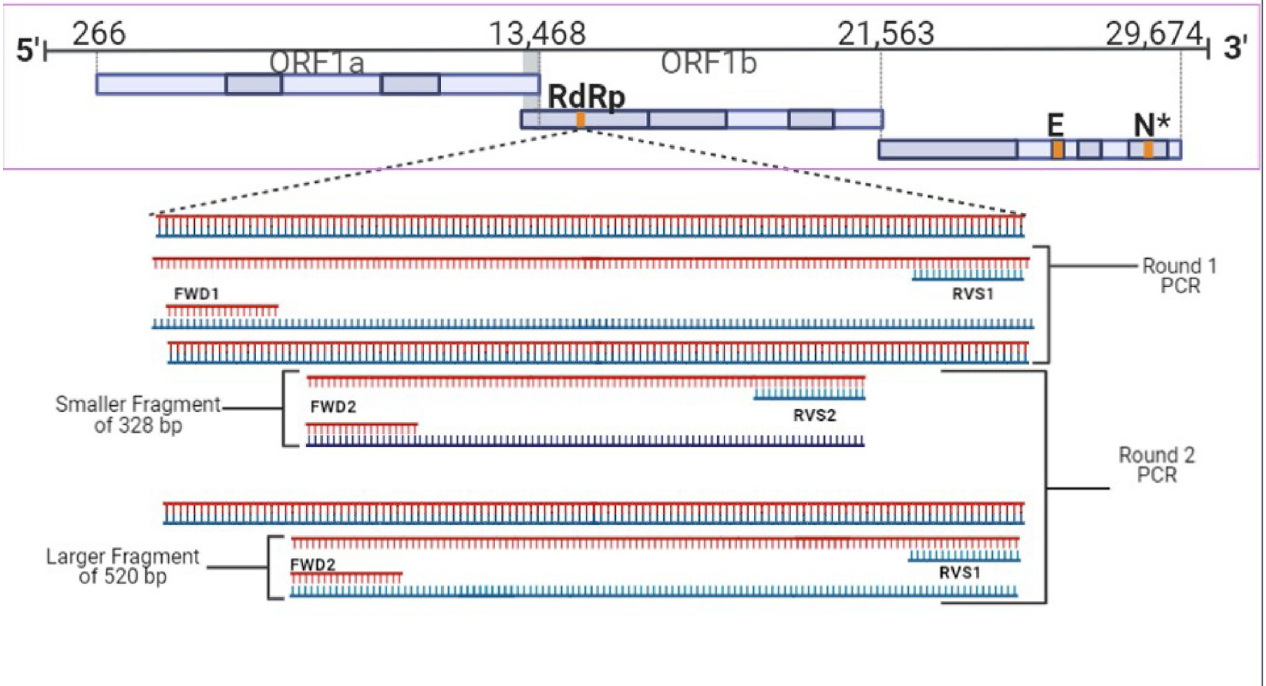
Fig 1. Nested PCR to detect coronavirus using two sets of primers (FWD1/RVS2 & FWD2/RVS1). Two PCR amplicons (328bp and 520bp) were produced, cleaned, and sequenced using Flongle MinION. The obtained sequences were BLAST analyzed in the NCBI database for viral taxonomic identification [3]. The images were created using the BioRender